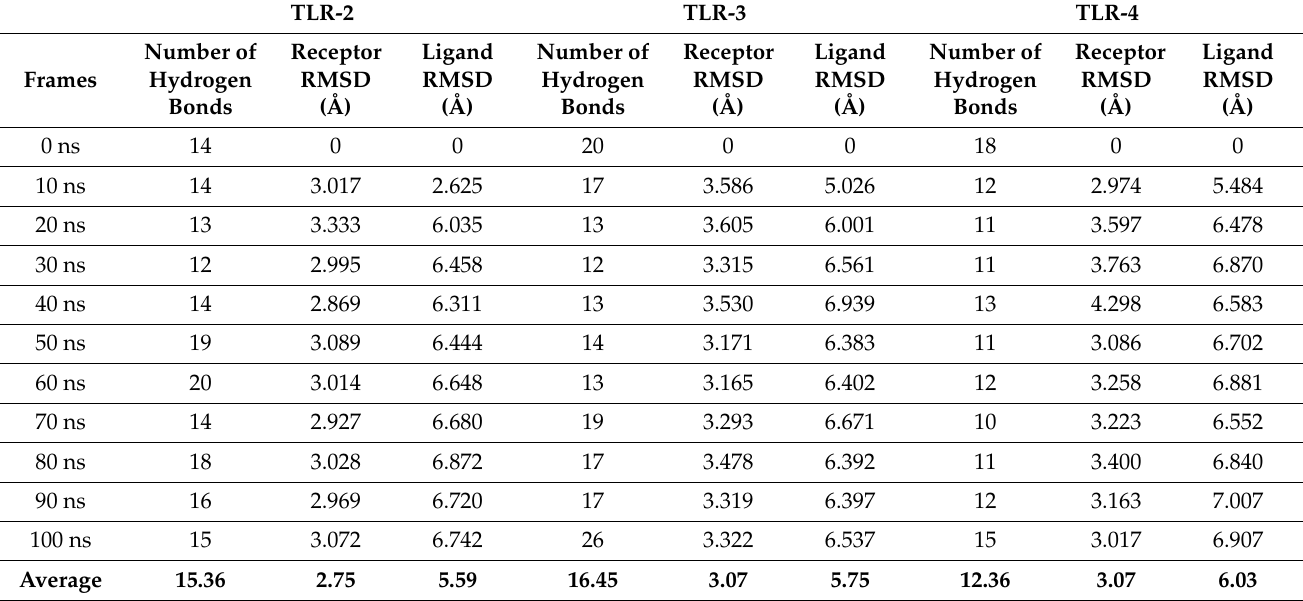
Table 5. Vaccine–receptor complex hydrogen bonds with different frames in MD simulation. TLR-2 TLR-3